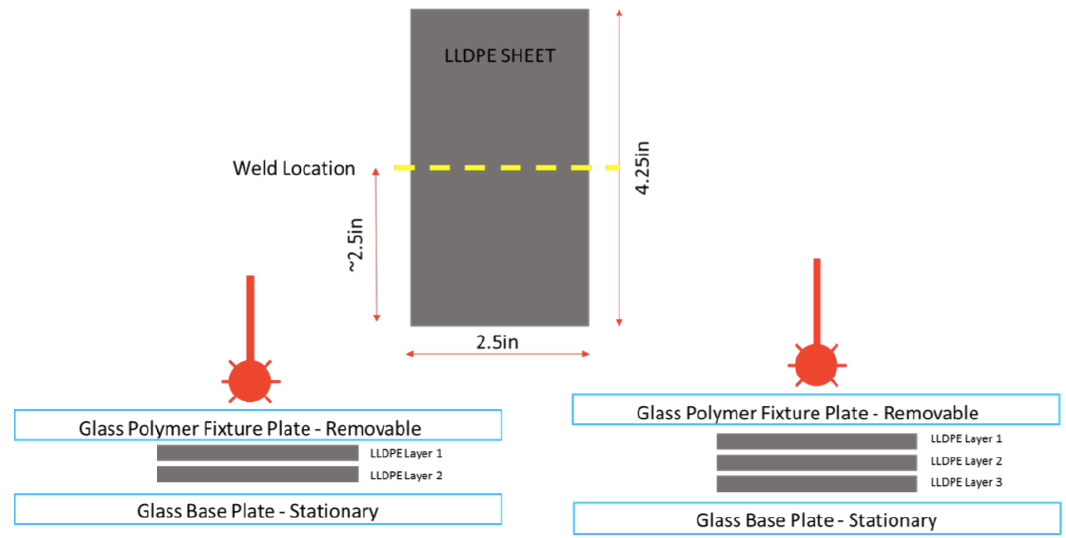
Figure 3. Sample dimensions and two/three layer experimental set up. Linear low density polyethylene (LLDPE), linear low density polyethylene.